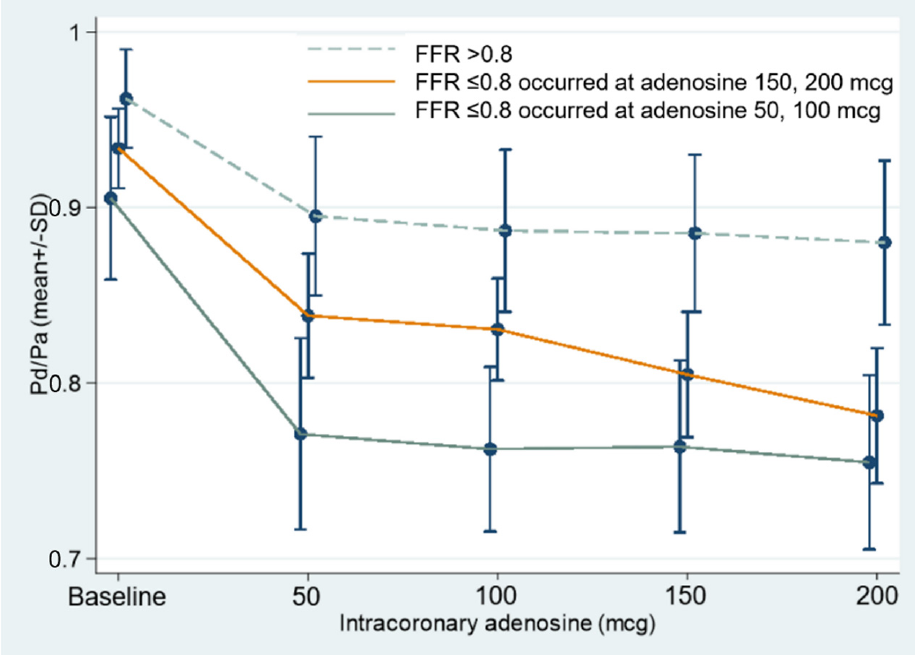
Figure 3. Three categories of changes in Pd/Pa value during FFR measurement: FFR > 0.8 (822 le- sions), FFR ≤ 0.8 occurring at adenosine 150, 200 mcg (47 lesions), and FFR ≤ 0.8 occurring at adenosine 50, 100 mcg (186 lesions). FFR—fractional flow reserve; Pd/Pa—ratio of pressure distal to coronary lesion divided by pressure of aorta; mcg—microgram.